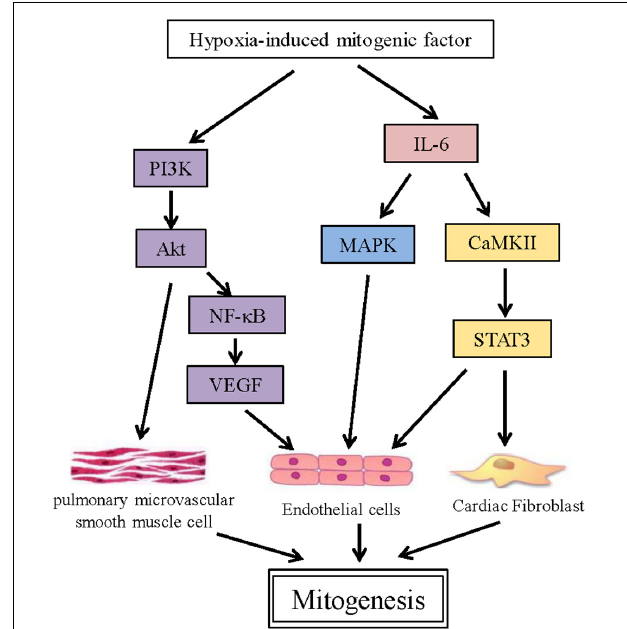
FIGURE 1 | HIMF links multiple mitogenesis-associated pathways. Schematic representing the direct target genes involved in various signaling pathways associated with mitogensis that are induced by